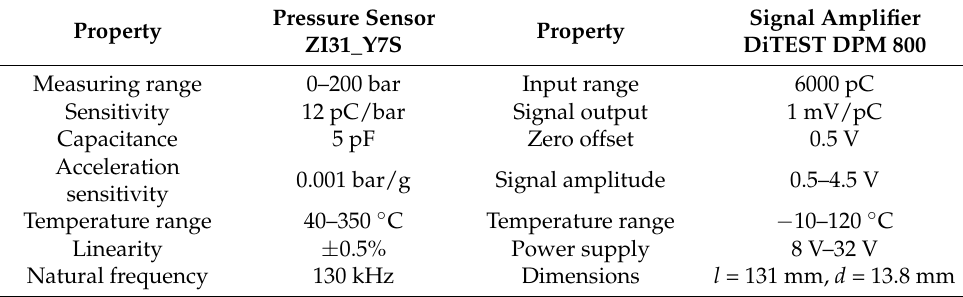
Table 2. In-cylinder pressure measuring equipment.